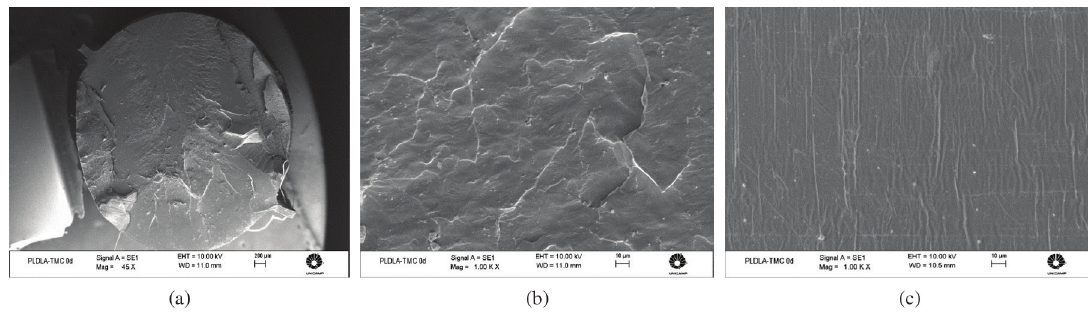
Figure 9. SEM micrographs of PLDLA-TMC pin. a) fracture surfaces b) surface. Magnifications bars 200 nm for (a), 10 nm for (b) and 10 nm for (c).